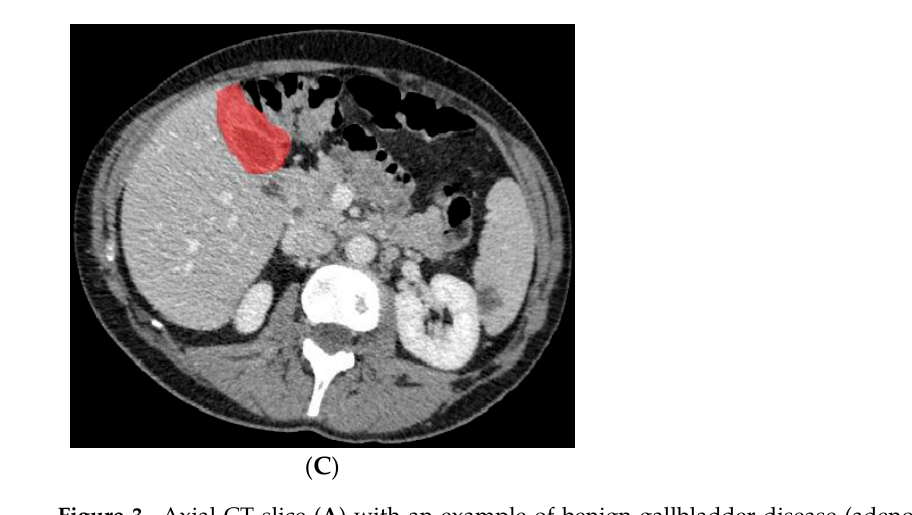
Figure 3. Axial CT slice ( A ) with an example of benign gallbladder disease (adenomyomatosis, encircled in B ) and subsequent segmented gallbladder ( C ).